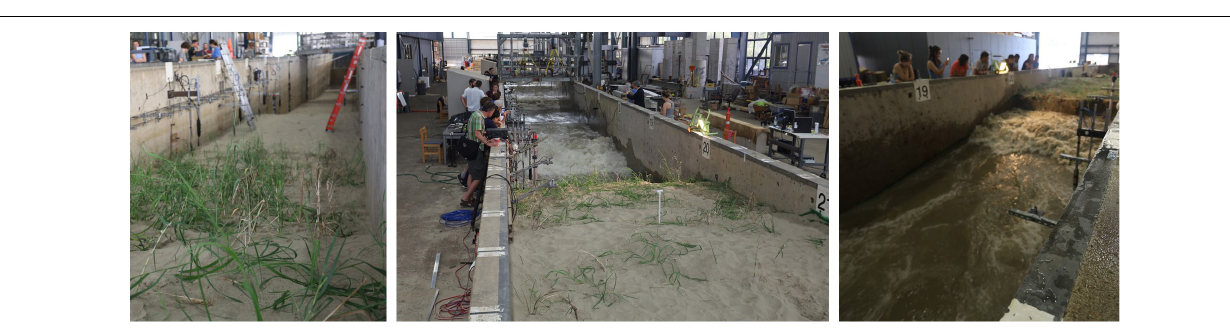
Frontiers in Built Environment |